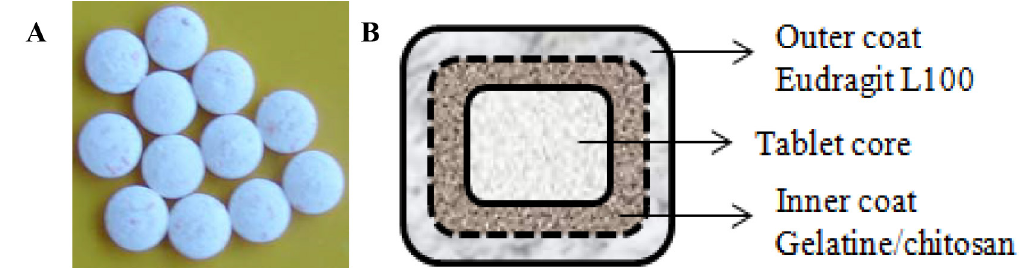
FIGURE 1 - Bilayer coated tablet. Bilayer coated tablet was prepared in this study (A); shematic of the bilayer coated tablet delivery system (not to scale) (B).